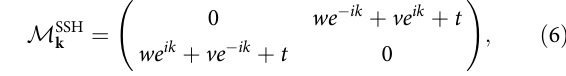
= 2 þ e ik = 2 Þ . The super- = 2 þ J A ′ e ik = 2 þ J B ð e (cid:3) ik ¼ J A e (cid:3) ik and Λ y b y b x a x a k scripts on each operator denote the two sublattices in the primitive unit cell. Quadratic terms from α = x , y , z are block- , re fl ecting that each band diagonalized into the same matrix, M k is triply degenerate owing to a rotation symmetry. Dispersion relations are obtained by applying Bogoliubov transformation: by diagonalizing the matrix Σ M ( Σ = diag(1, 1, − 1, − 1)), disper- k sion relations are obtained as ffiffiffiffiffiffiffiffiffiffiffiffiffiffiffiffiffiffiffiffiffiffi